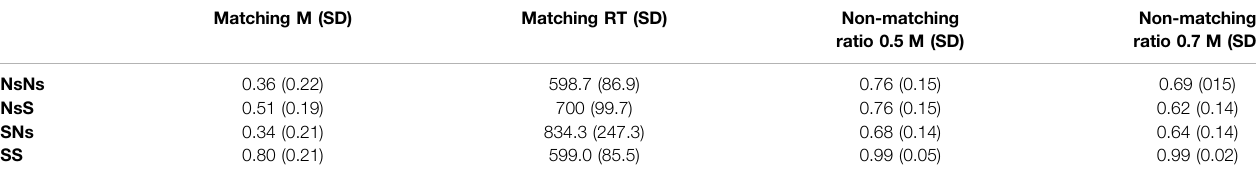
TABLE 1 | Mean proportion correct and standard deviations for matching and non-matching trials per